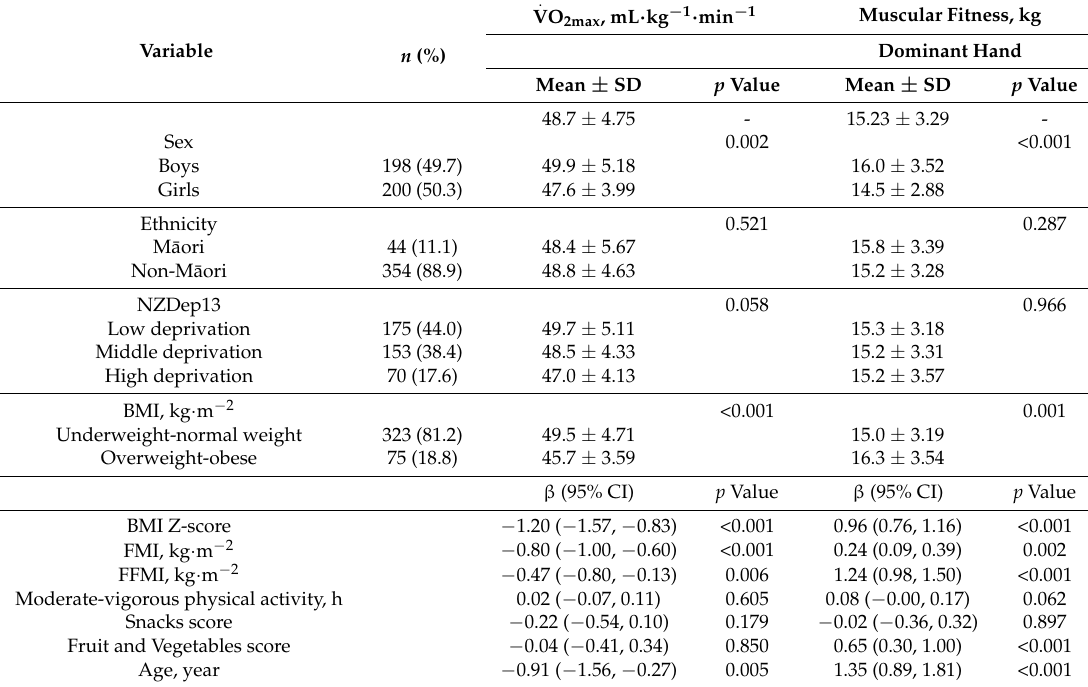
Table 1. Bivariable predictors of CRF and muscular